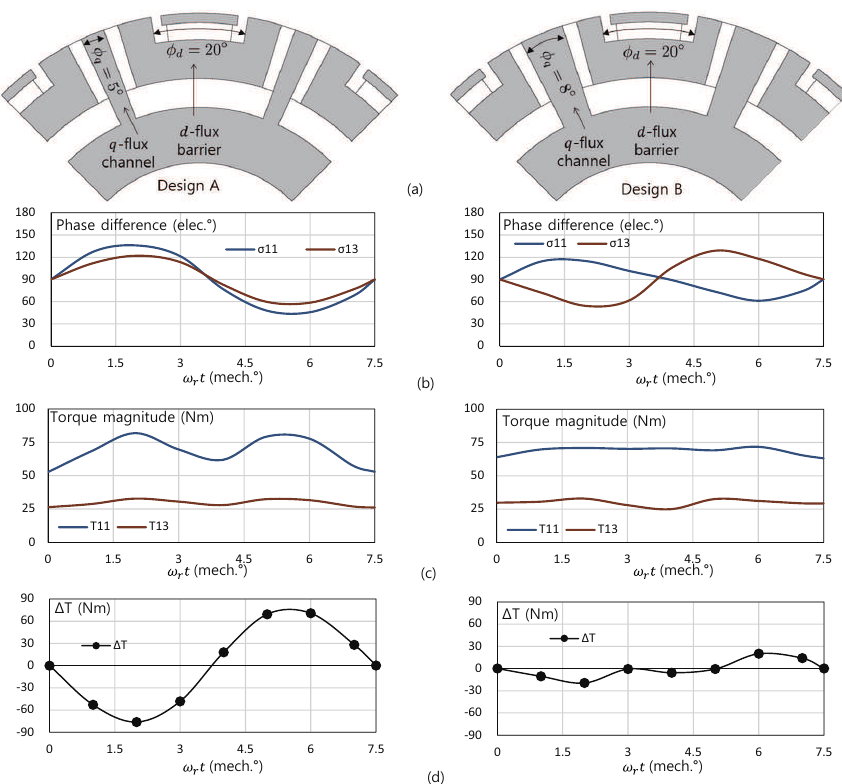
Figure 6. Comparisons of time-stepping plots in 11th and 13th torque components for Design A and B: ( a ) rotor configuration, ( b ) phase differences σ 11 and σ 13 , ( c ) torque magnitude T 11 and T 13 , ( d ) ∆ T